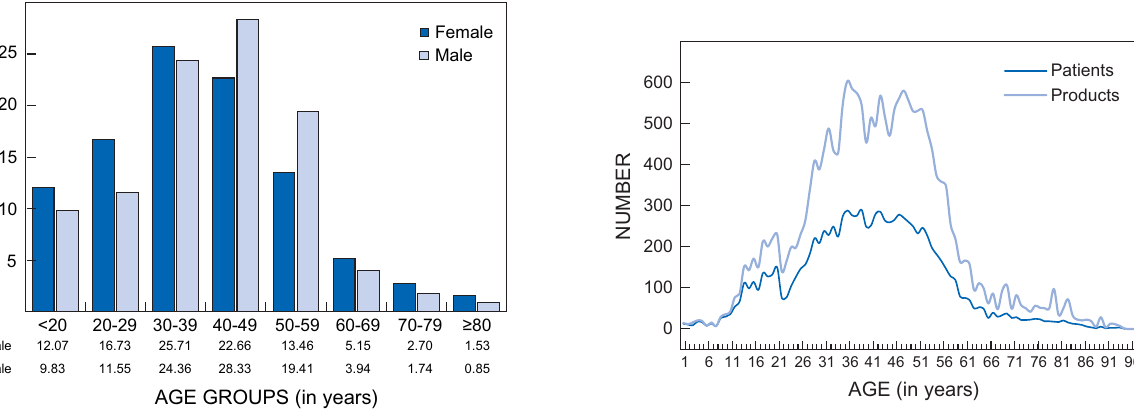
Figure 1: Percentage age and gender distribution of patients prescribed meprobamate ( n = 10 404).